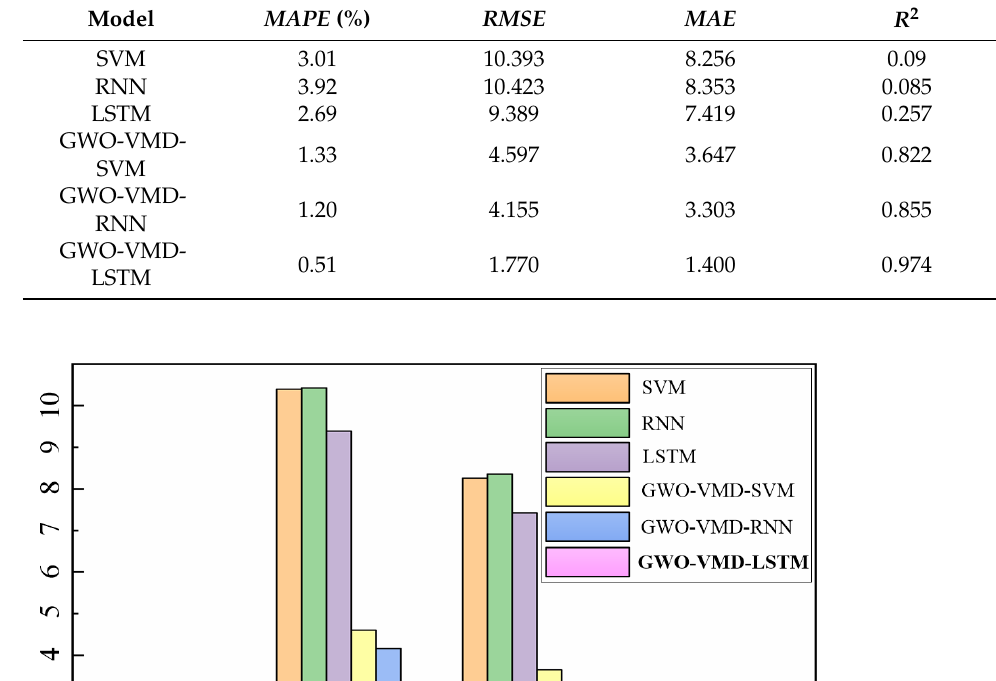
Table 3. Performance prediction for each model of selected dataset.